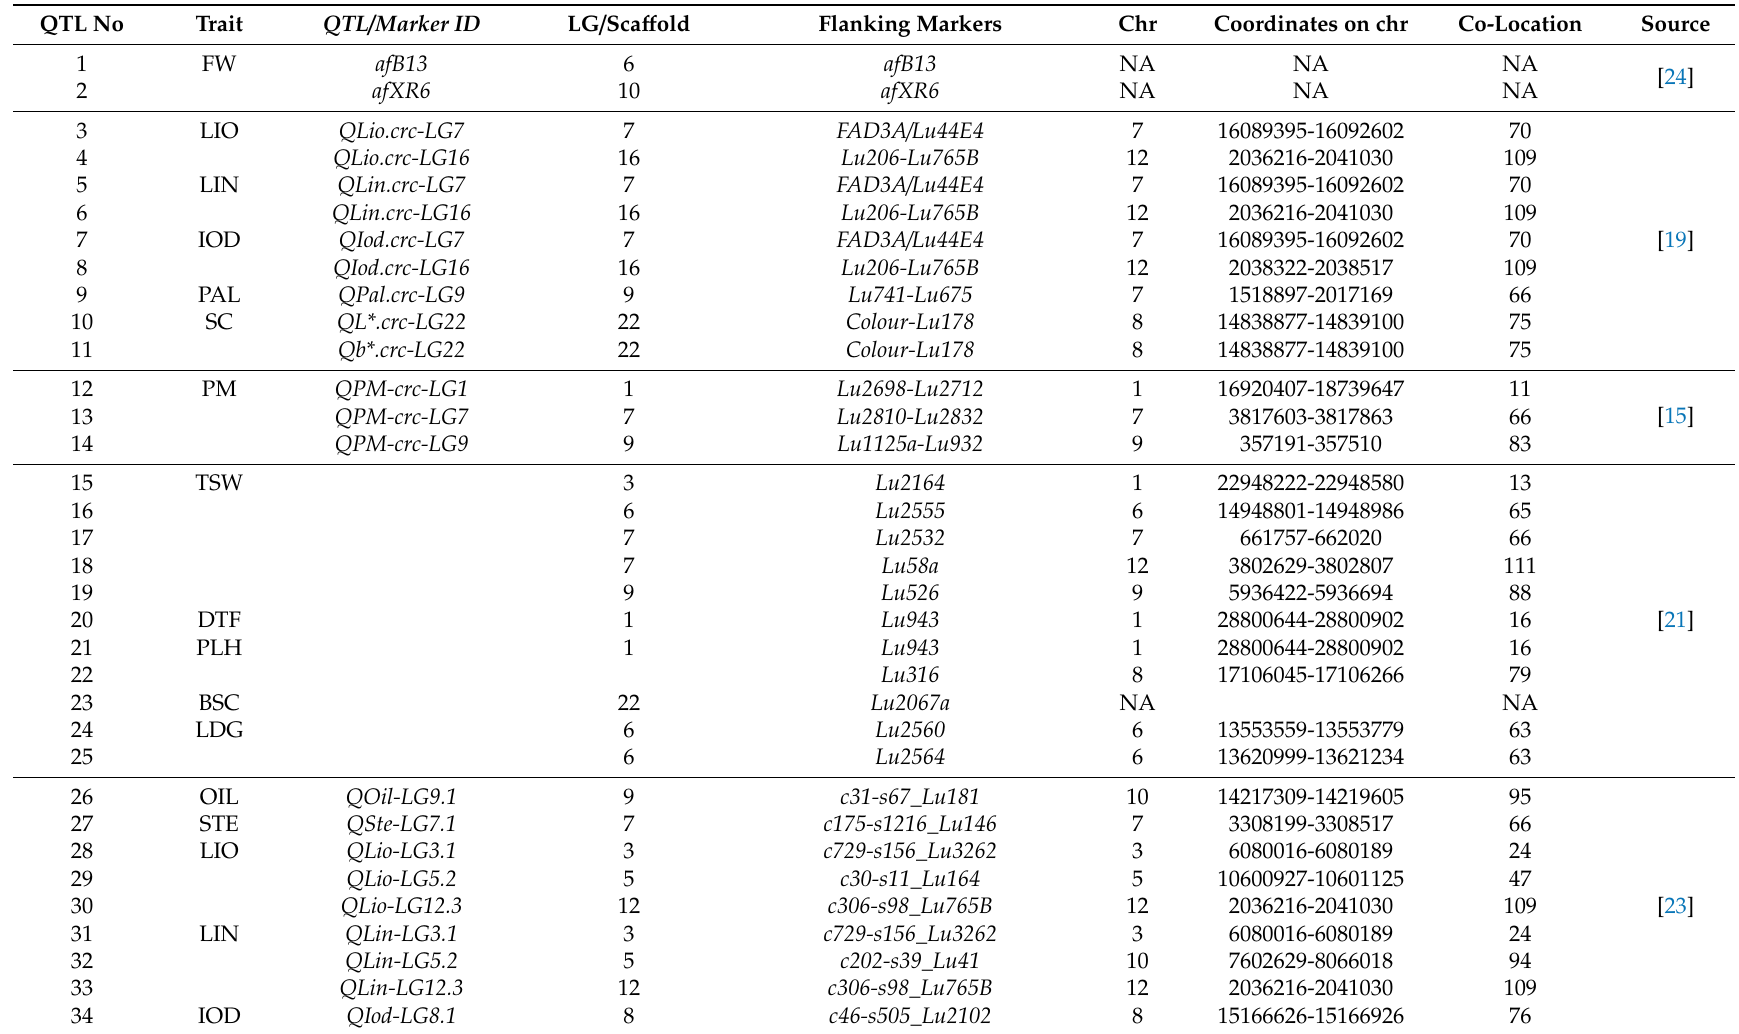
Table 3. QTL mapped to the recently released chromosome-scale